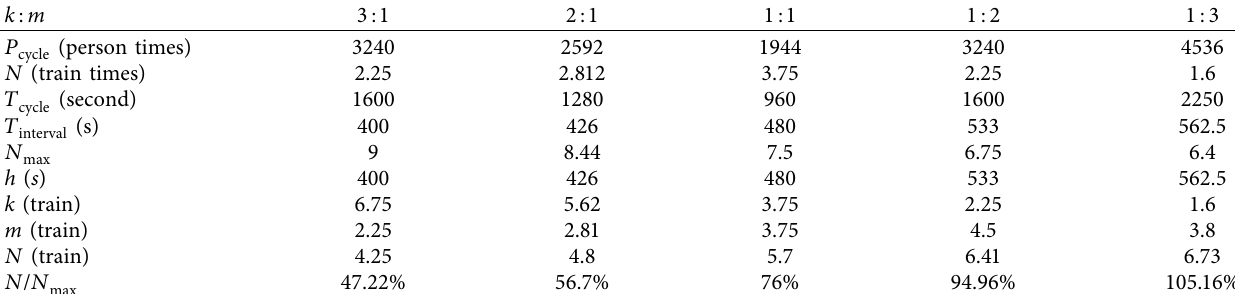
Table 4: Line indicators under the proportion of express and local